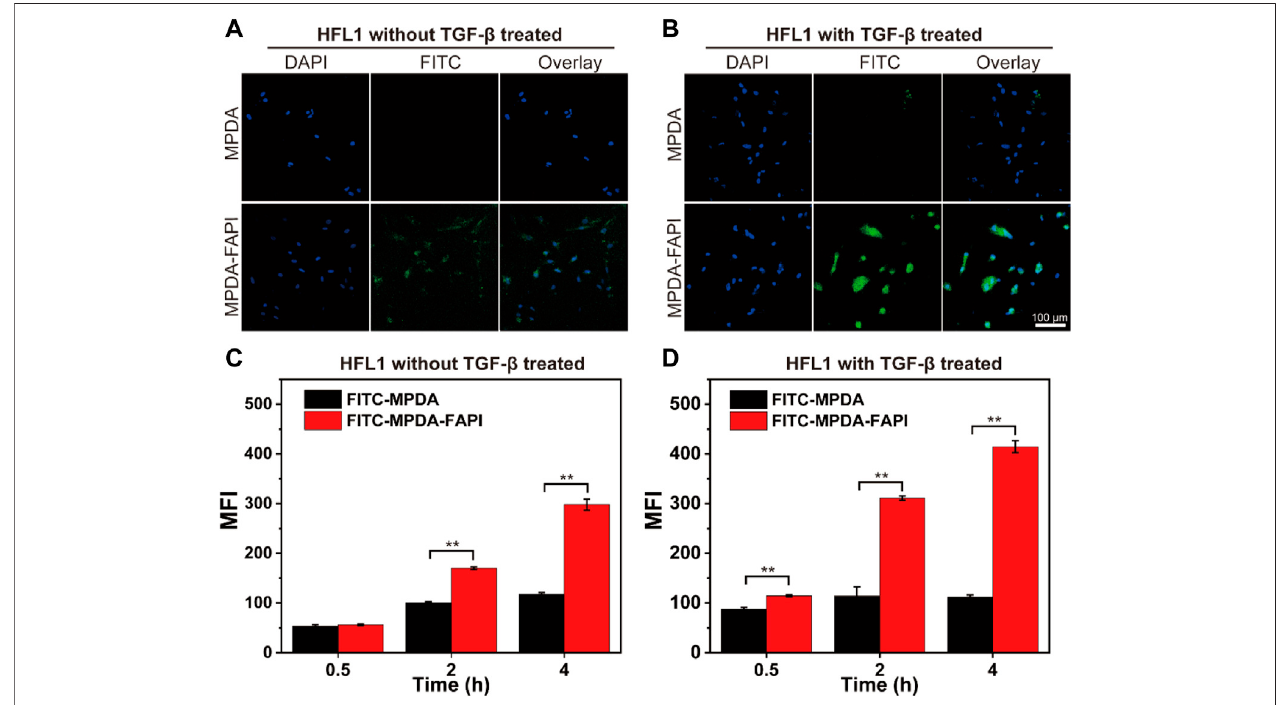
FIGURE 3 | (A,B) CLSM images of HFL1 cells (treated without/with TGF- β ) uptake MPDA and MPDA-FAPI for 4 h. (C,D) Flow cytometer result of HFL1 cells (treated without/with TGF- β ) uptake of MPDA and MPDA-FAPI (** p <